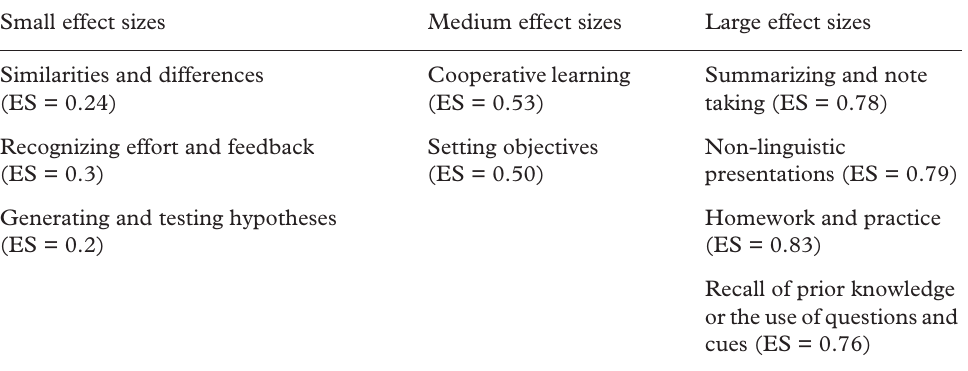
Table 2. Comparison of effect sizes